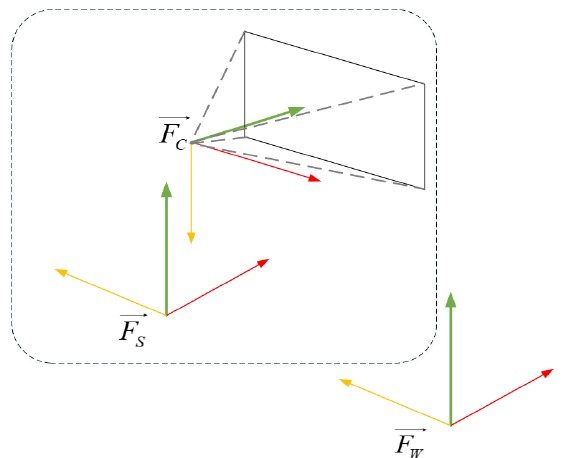
Figure 2. Coordinate frames involved in the system. Image data is acquired in F (cid:3030) (cid:4652)(cid:4652)(cid:4652)(cid:4652)(cid:3377) , and IMU data is acquired in F (cid:3046) (cid:4652)(cid:4652)(cid:4652)(cid:3377) . The poses and feature points need to be estimated are represented in F (cid:3050)